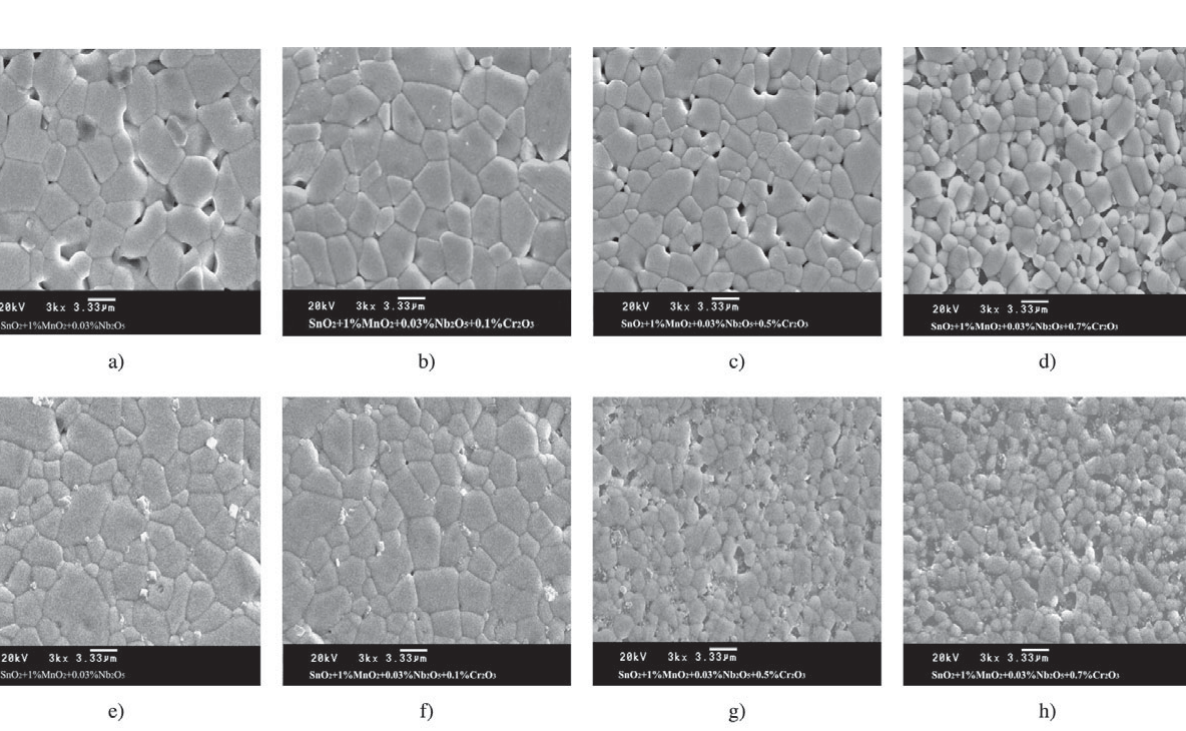
Figure 3. a) SEM micrographs of sintered compacts at 1300 °C for 3 h, prepared by Pechini method, with: (a) 0.0% mol of Cr.; b) 0.1% mol of Cr; c) 0.5% mol of Cr; d) 0.7% mol of Cr; and prepared by mixture of oxides, with: e) 0.0% mol of Cr; f) 0.1% mol of Cr; g) 0.5% mol